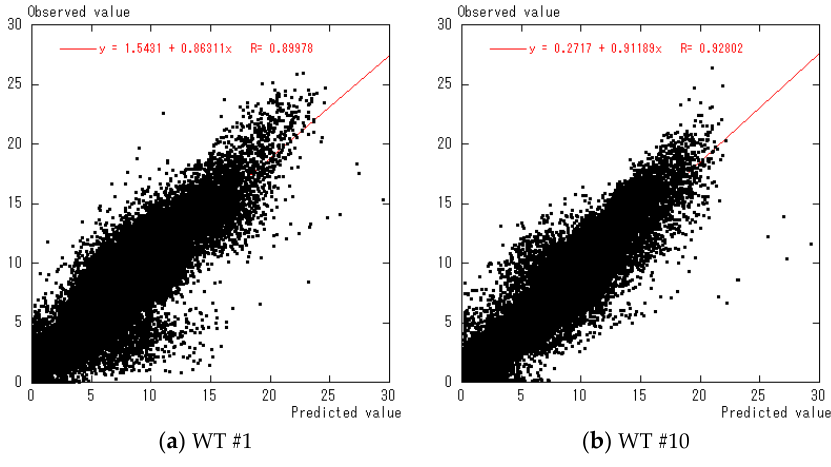
Figure 12. Scatter plots of observed and predicted wind speed, reference point: WT #6.